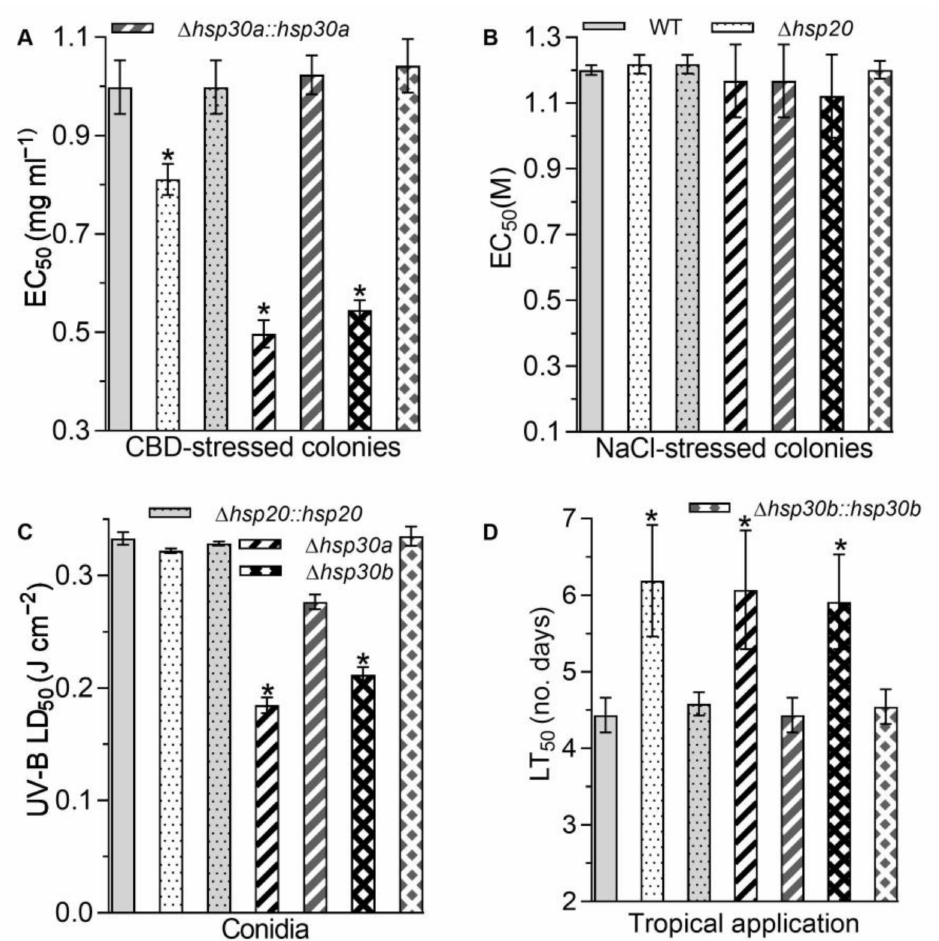
Figure 5. Phenotypic changes in response to carbendazim (CBD), NaCl, and UV-B irradiation and fungal virulence caused by the deletion of hsp20 , hsp30a , and hsp30b in B. bassiana. ( A ) EC 50 for CBD to suppress 50% colony growth of each strain after 6 d incubation at 25 ◦ C on 1/4 SDAY plates. ( B ) EC 50 for NaCl to suppress 50% colony growth of each strain after 6 d incubation at 25 ◦ C on 1/4 SDAY plates. ( C ) LD 50 estimates for conidial resistance to UV-B irradiation. ( D ) LT 50 for the virulence of each strain against G. mellonella larvae infected by topical application. Asterisked bars in each bar group differ significantly from those unmarked (Tukey’s HSD, p < 0.05). Error bar: SD from three